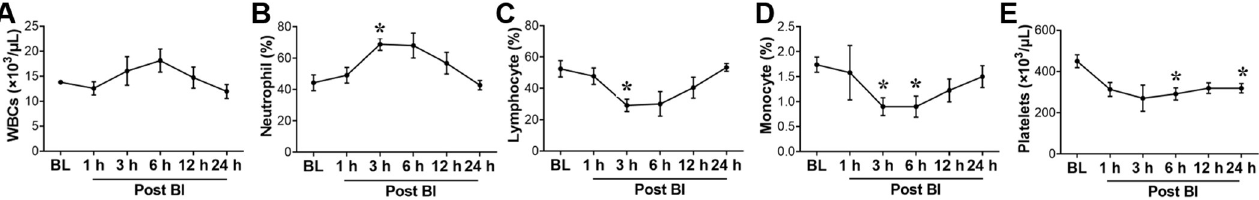
Figure 1. Circulating alterations of WBCs ( A – D ) and platelets ( E ) in a porcine BI+HS model. The data are presented as mean ± SD (n = 5). * p < 0.05 vs. BL.